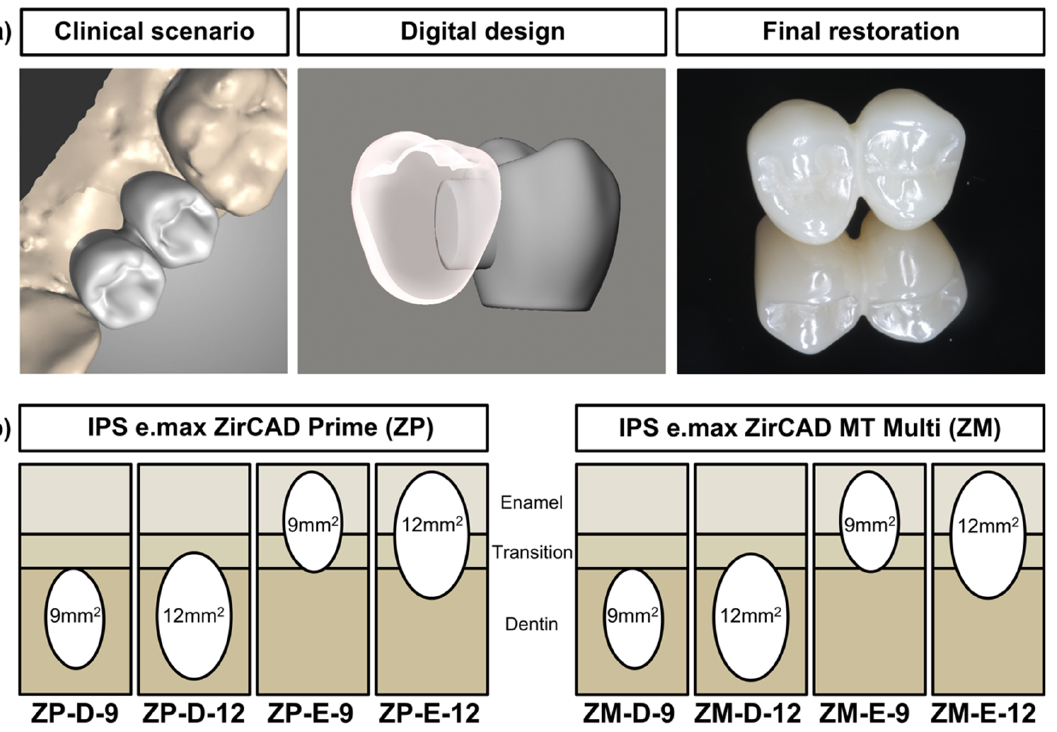
Figure 1. Set-up of the study: ( a ) implant cantilever fixed dental prostheses design; ( b ) specimens were designed with a connector size of either 9 or 12 mm 2 and positioned in the disc within the enamel (E) or dentin (D) layer of zirconia material ZP and ZM.